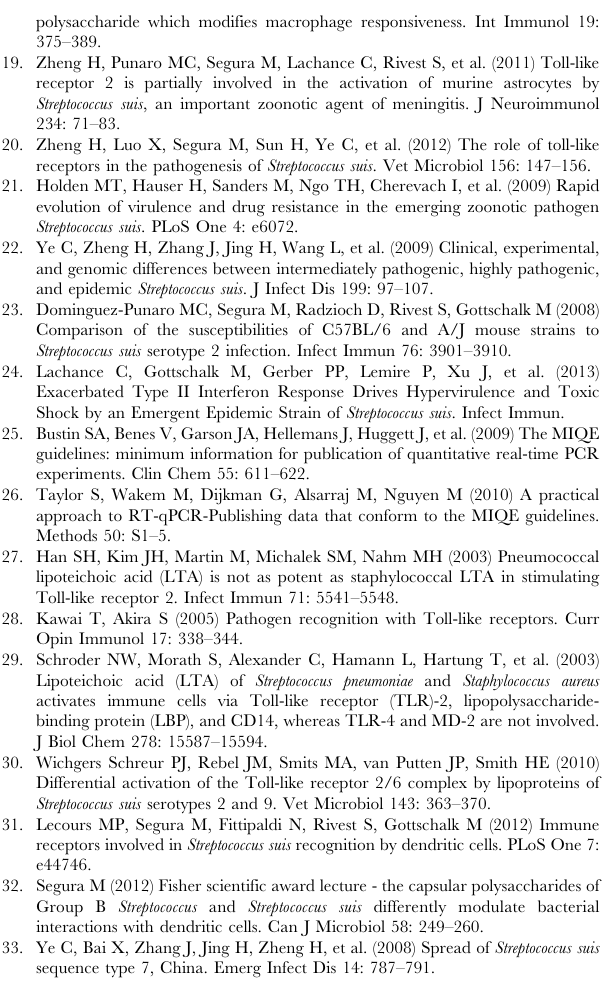
Table S1 Genes upregulated greater than three-fold in wild type C57BL/6 (B6) or TLR2 2 / 2 mice infected with either S. suis P1/7 (ST1) strain or epidemic SC84 (ST7) strain for 6